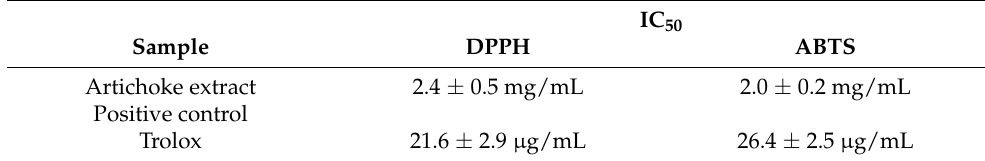
Table 3. IC 50 values of the extract and Trolox, used as positive control, against DPPH and ABTS radicals.